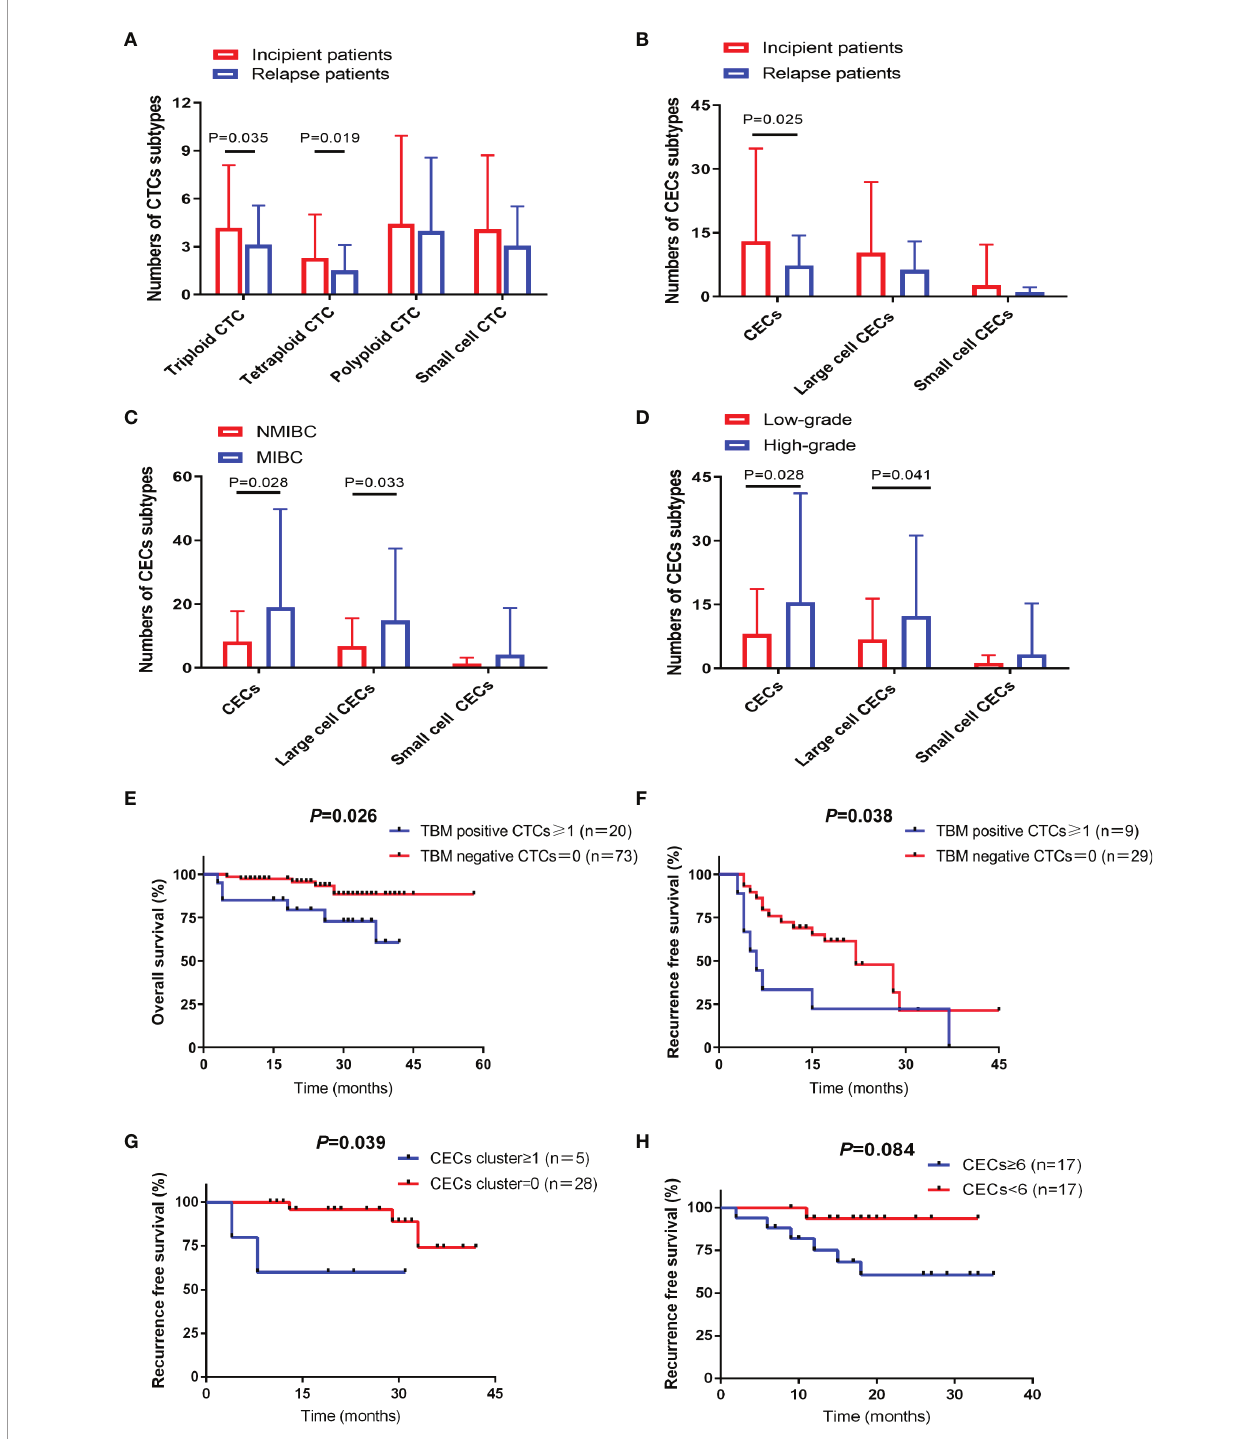
FIGURE 2 | CTC and CEC subtypes correlated with different clinical characteristics and prognosis. (A) Distribution of CTC subtypes in incipient and relapse bladder- cancer patients. (B) Distribution of CEC subtypes in incipient and relapse bladder-cancer patients. (C) Distribution of CEC subtypes in bladder-cancer patients according to tumor stage. (D) Distribution of CEC subtypes in bladder-cancer patients according to tumor grade. (E) TBM-positive CTC number ≥ 1 showed poor prognosis with shorter OS in NMIBC patients receiving TURBT. (F) TBM-positive CTC number ≥ 1 showed poor prognosis with shorter RFS in high-risk NMIBC patients receiving TURBT. (G) CEC cluster number ≥ 1 showed poor prognosis with shorter RFS in high-risk NMIBC patients receiving TURBT. (H) CECs number ≥ 6 showed poor prognosis with shorter RFS in MIBC patients receiving